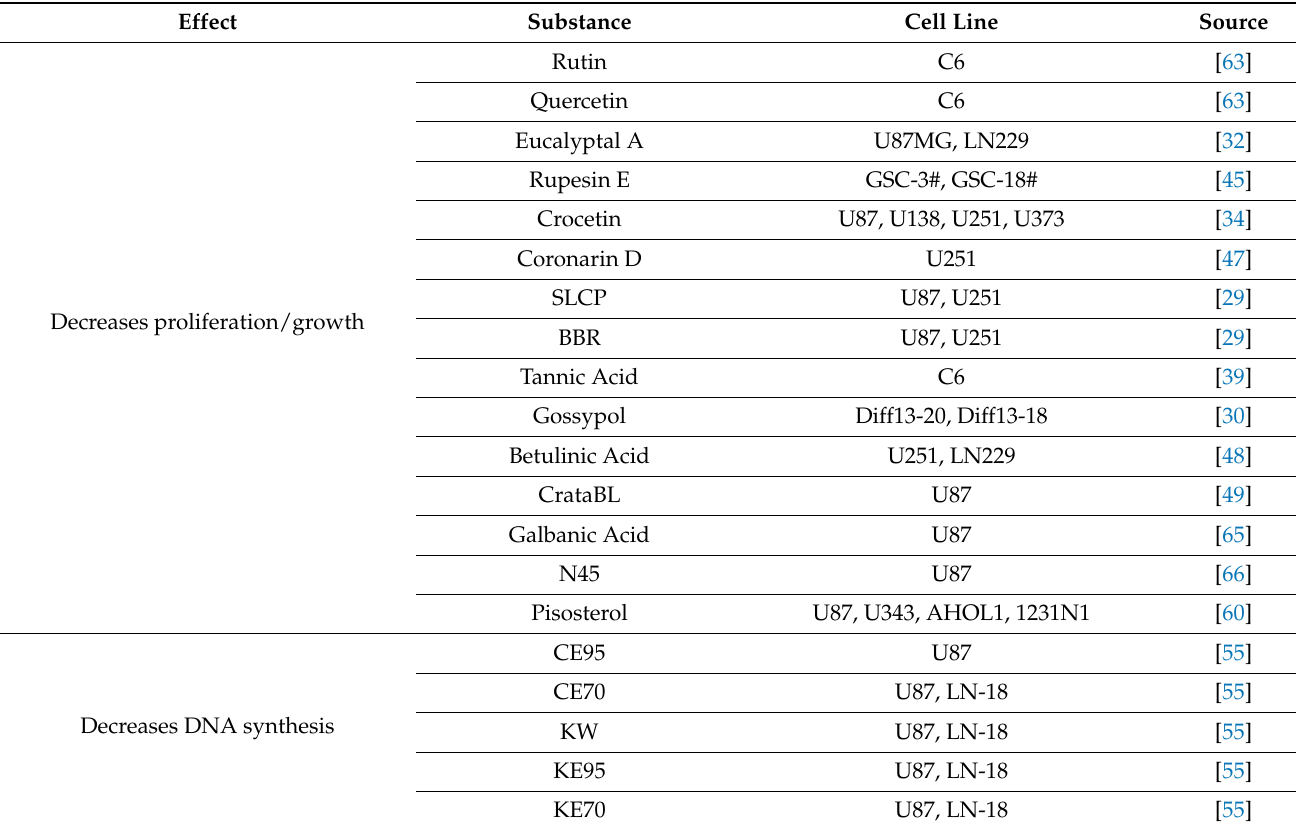
Table 3. Natural substances decrease proliferation in GBM by downregulating upstream growth factors and chemokine ligands, components of the Ras/Raf/MEK/ERK and PI3K/Akt pathways, and downstream